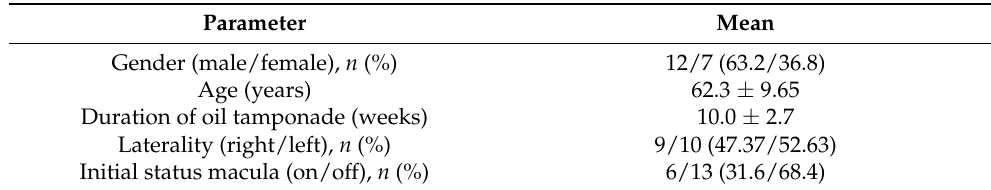
Table 1. Demographic and clinical characteristics of the study cohort. Data are presented as mean ± standard deviation.